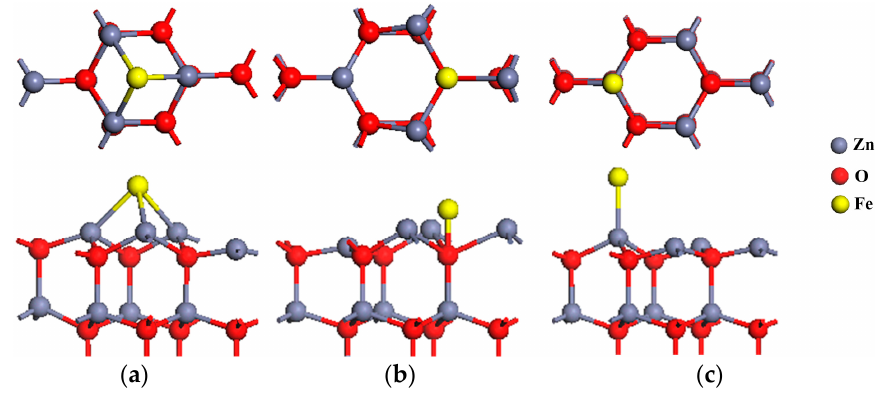
Figure 3. The side and top view of the optimized structures of iron atom adsorbed on ( a ) the H 3 site; ( b ) the T 4 site; ( c ) the Top site of ZnO (0001) surface.